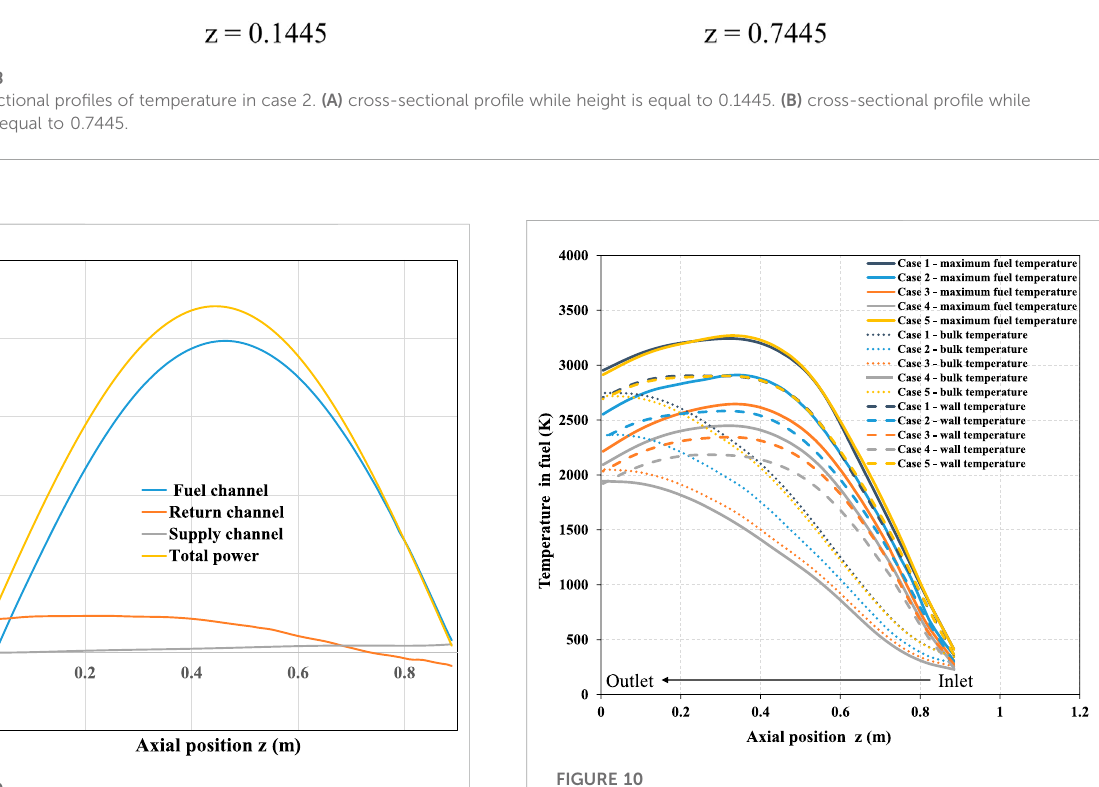
FIGURE 10 Maximum fuel center temperature, bulk temperature, and wall temperature in fuel channel vary among different